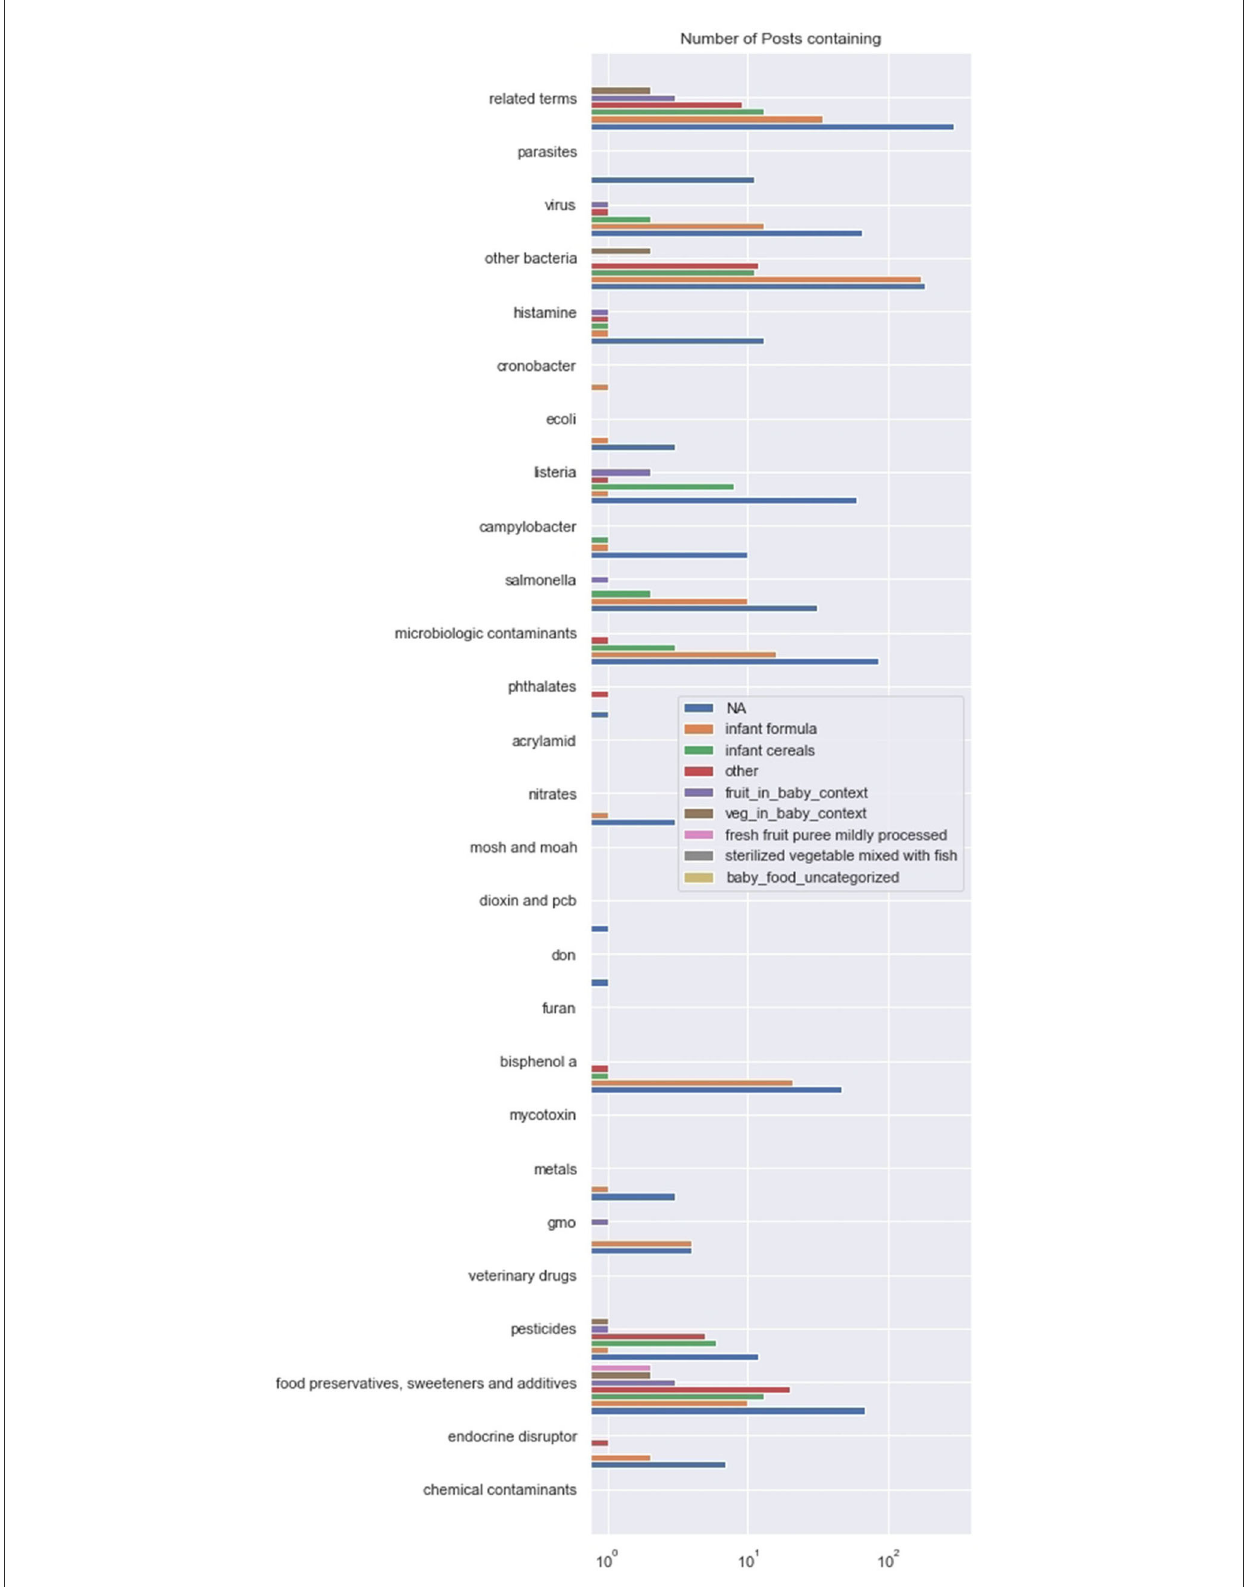
FIGURE3 Product-hazard co-occurrences. The pairs (product, hazard) correlated at the 5% level, and their correlations, are: (jarred foods, microbes, 0.35), (formula, bacteria, 0.26), (jarred foods, pesticides, 0.16), (baby foods, preservatives,